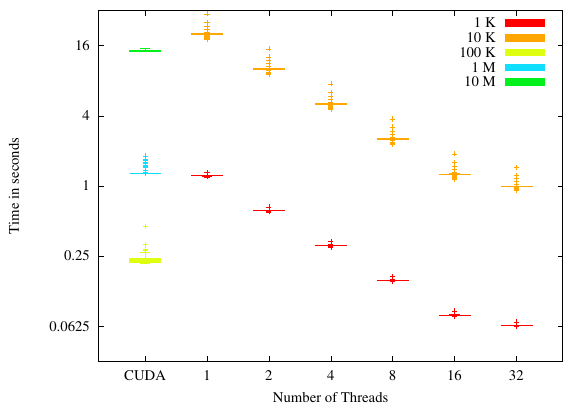
Figure 6. Execution time for predicting one step of cloud